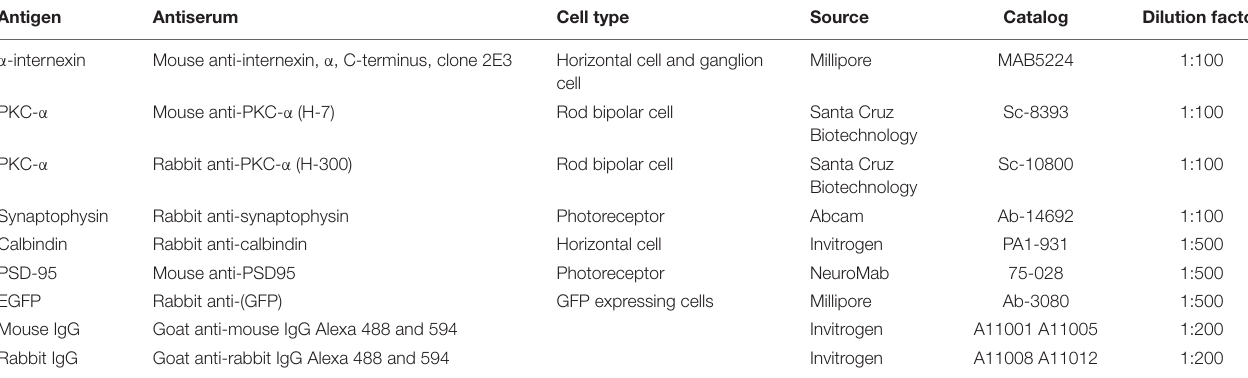
TABLE 1 | List of antibodies applied for